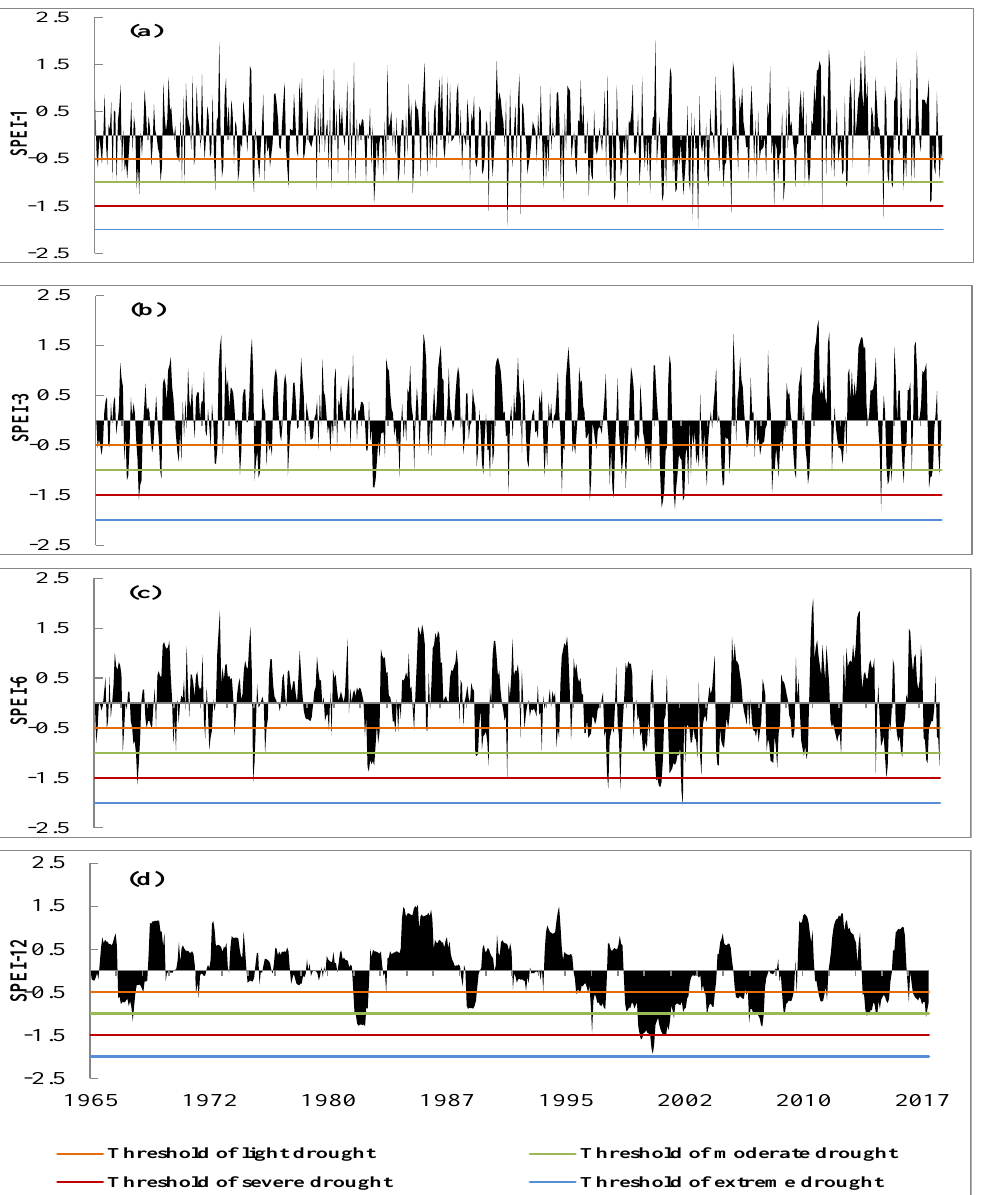
Figure 4. Time series variability of SPEI-1 ( a ); SPEI-3 ( b ); SPEI-6 ( c ); and SPEI-12 (d ) in the time period 1965 – 2017.